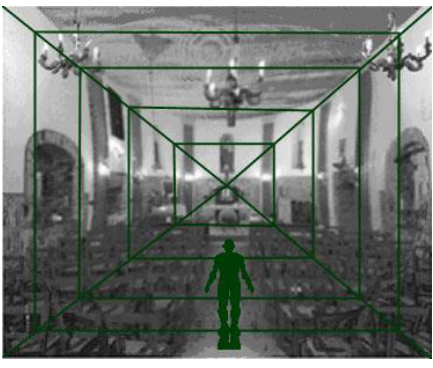
Figure 7. Virtual Reality.